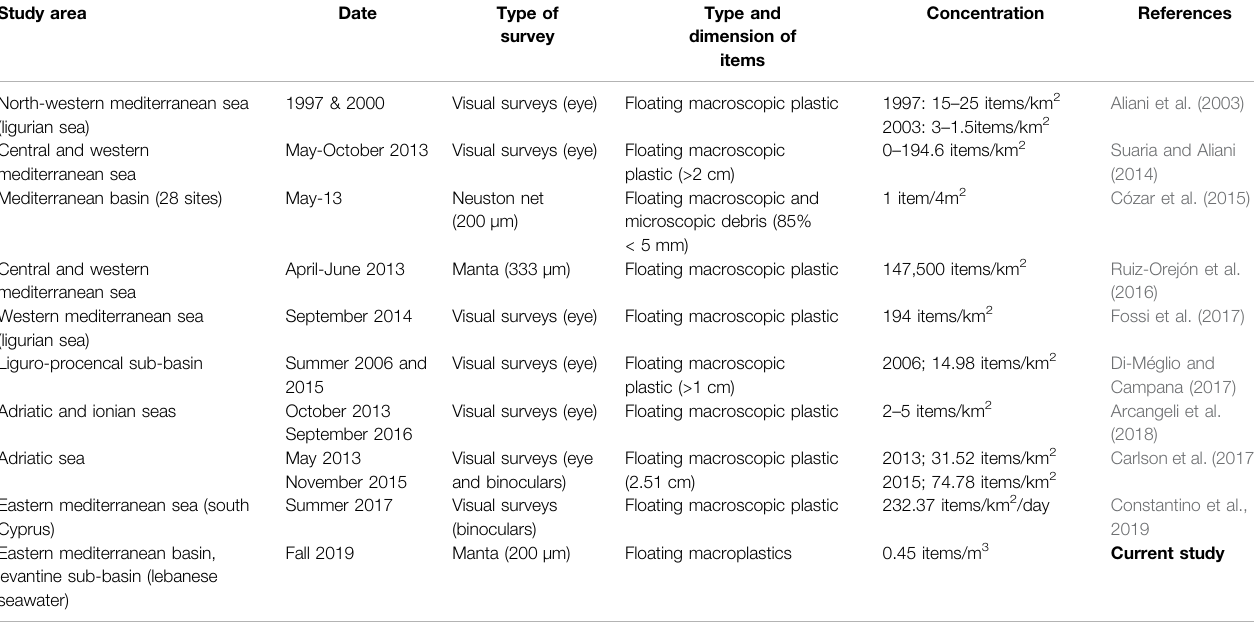
TABLE 3 | The concentration of macroplastics from different areas of the Mediterranean Sea.